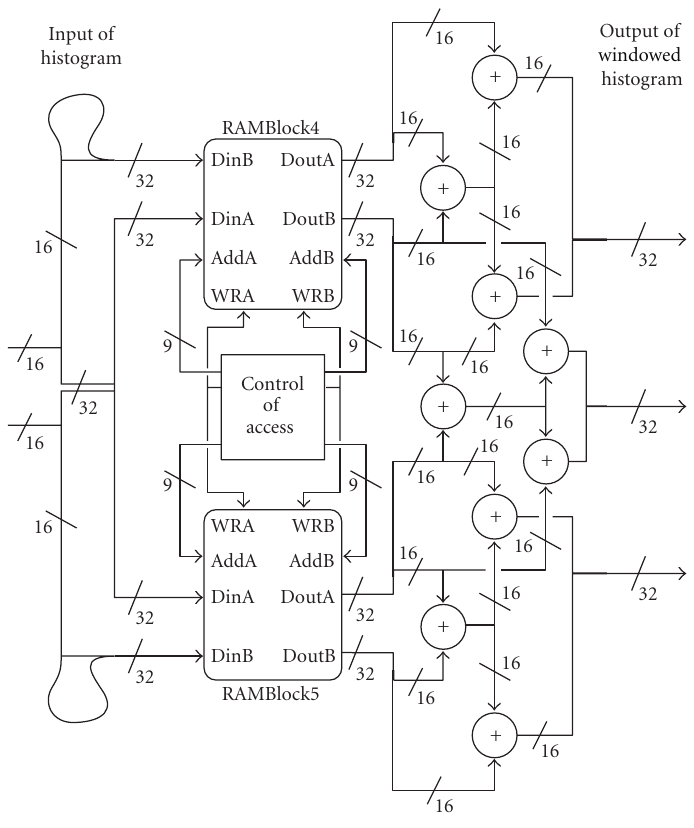
Figure 4: Circuit for calculating the windowed terms.